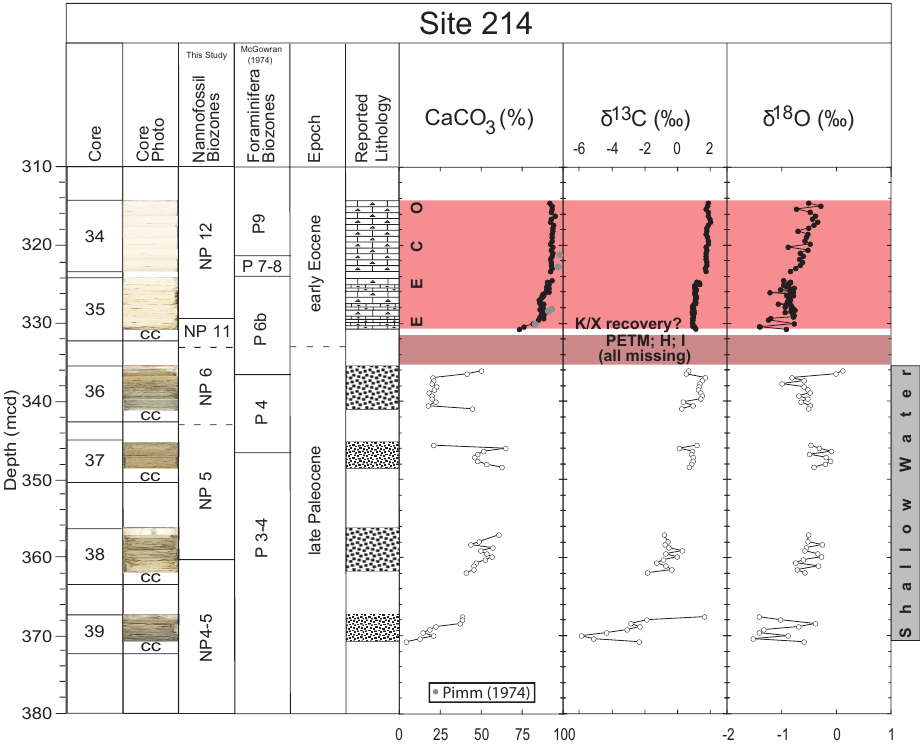
Figure 8. Early Paleogene sequences at DSDP Site 214. Biostratigraphy and lithology have been modified from the DSDP Leg 22 volume (von der Borch and Sclater, 1974). Core photos are sourced from the online database (www.iodp.org). Carbonate content records include data from previous work (grey – Pimm, 1974). Numerous hyperthermals, including the PETM, H events, I events, and K/X, are missing in the hiatus in the core gap between cores 36 and 35. It is possible that the uppermost recovery interval of the K/X event spans the base of core 35, where already elevated carbonate contents increase slightly. Calcareous nannofossil NP biozones from Martini (1971) and foraminiferal P biozones from Berggren et al. (1995). Note lithological facies key in Fig.